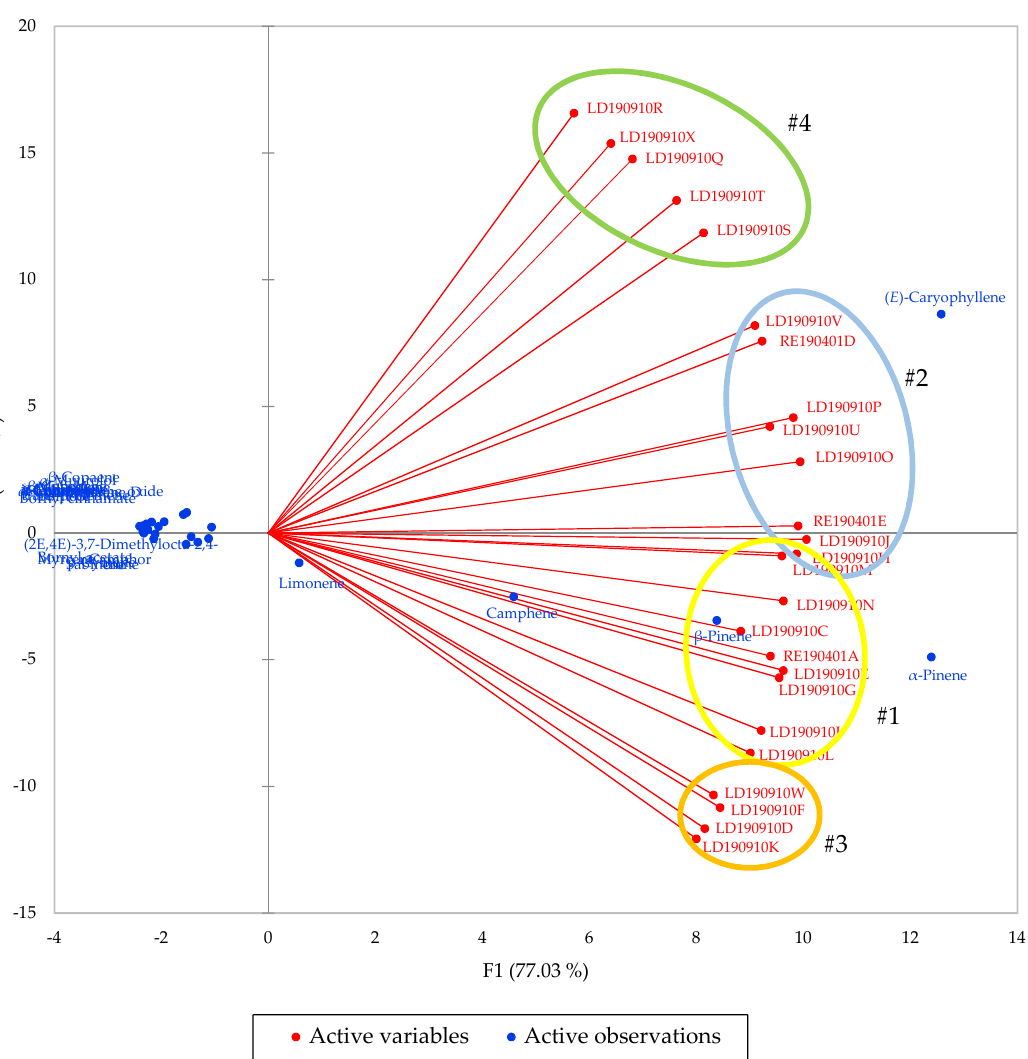
Figure 2. Principal component biplot of PC1 and PC2 scores and loadings indicating the chemical groupings of Liquidambar formosana based on compositions of the oleoresin essential oils.